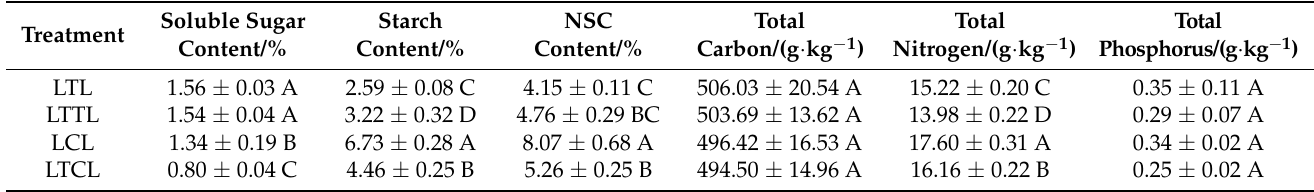
Table 3. Initial physical and chemical properties of Chinese fir topsoil and canopy